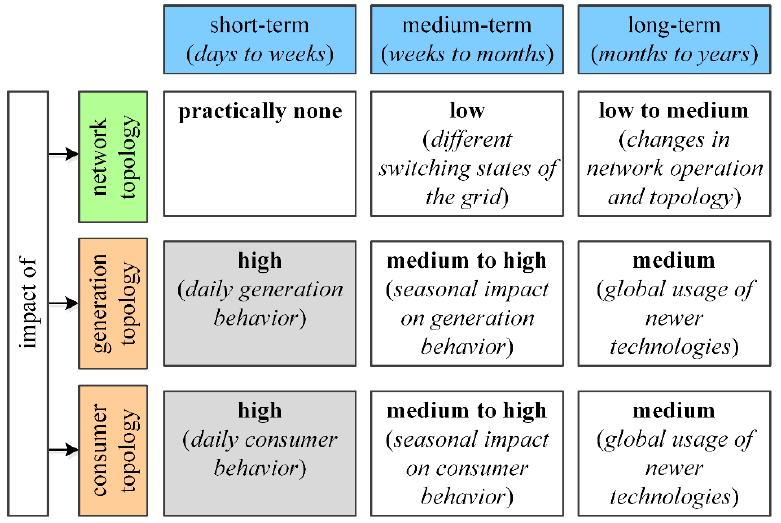
Figure 1. Classification of variation types and major impact factors in public LV networks [8].